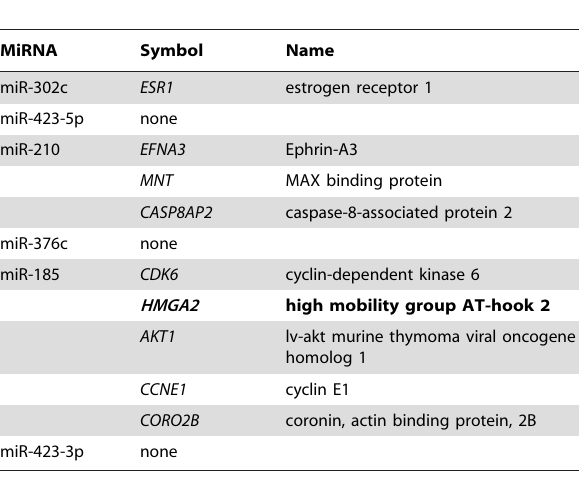
Figure 4. Argonaute1 (A) and Argonaute 2 (B) expression in normal and IPF patient lung biopsies. Total RNA from SLBs was analyzed by qRT-PCR for transcript expression. Relative expression values were normalized to the normal group (n=10) and compared to the slowly progressive (n=6) or rapidly progressive group (n=9). Expression values were also normalized to GAPDH. Data are presented as mean 6 SE. Significant differences are shown as *P # 0.05.